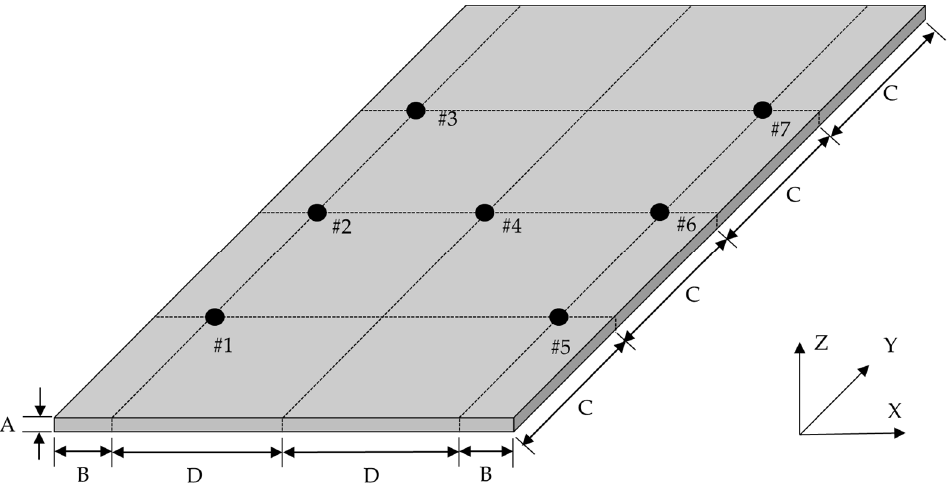
Figure 2. Configuration of simple rectangular specimen and sensor attachment locations: A: 3 mm, B: 10 mm, C: 37.5 mm, D: 30 mm [22,23].